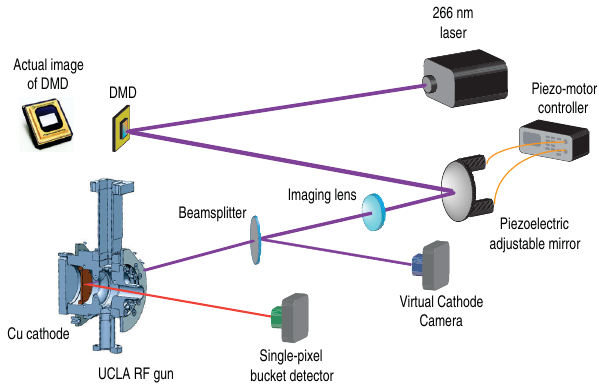
FIG. 1. Simplified schematic of the UCLA experiment. A 266 nm laser illuminates 240 × 240 pixels on the DMD, which contains a programmable mask. The transversely-shaped laser then reflects off of a UV-enhanced metal mirror that is mounted on a piezoelectric kinematic mirror mount that can be electroni- cally adjusted along two axes. The laser is then imaged onto a Cu cathode with a magnification factor of 3.8 using a lens with a 75 cm focal length. A small portion of the beam is split using a beam-splitter upstream of the cathode and is directed onto a screen located at the imaging plane of the lens and monitored by a virtual cathode camera